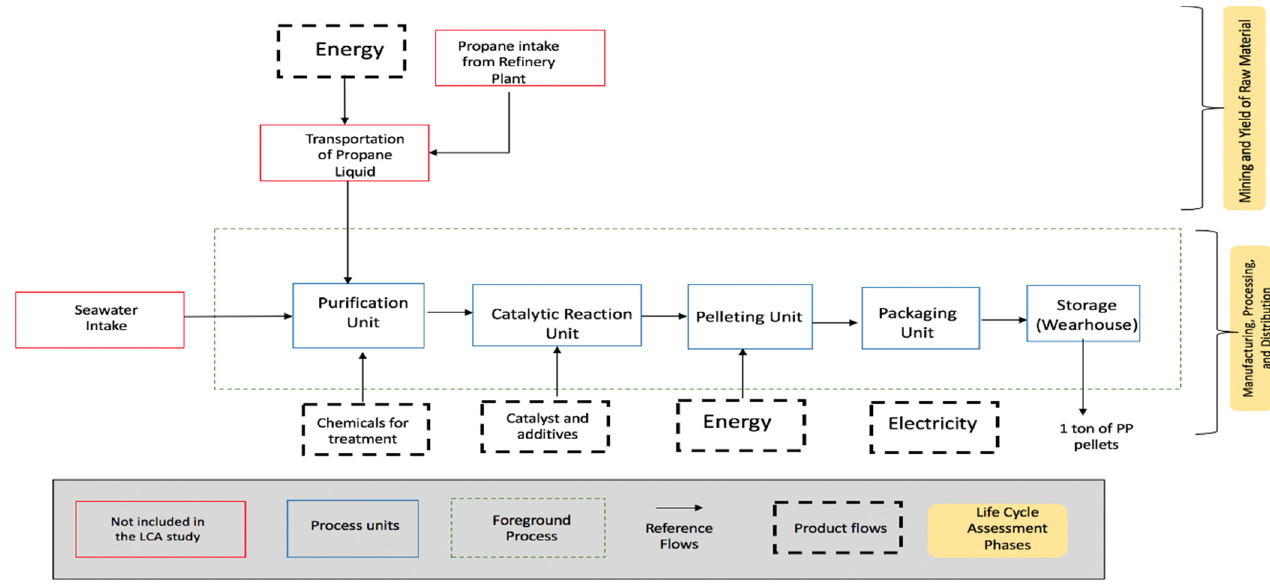
Figure 3. System boundaries for each unit in the PP manufacturing plant considered in this LCA study. The life cycle phases have been highlighted, while the construction of this plant, production of raw material, usage of PP, and the end-life scenarios for PP have been excluded from this LCA study.